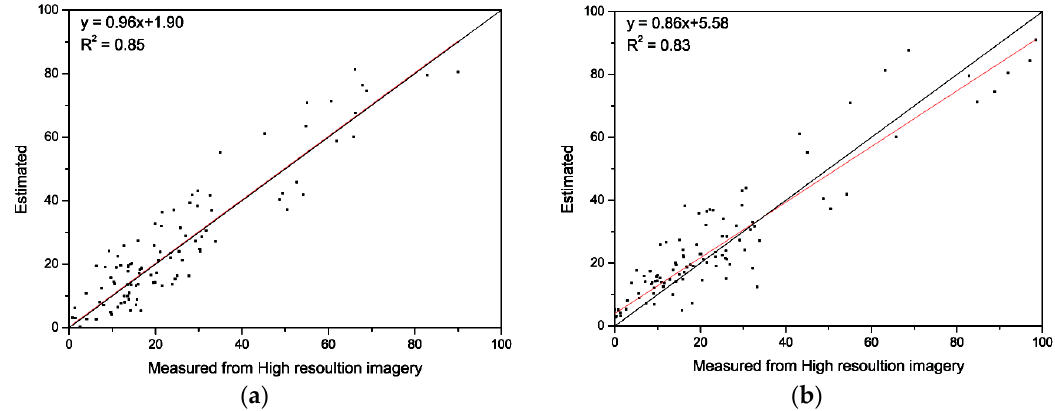
Figure 5. Accuracy assessment results of ( a ) estimated vegetation fraction coverage (VFC) and ( b ) estimated impervious surface coverage (ISA%).